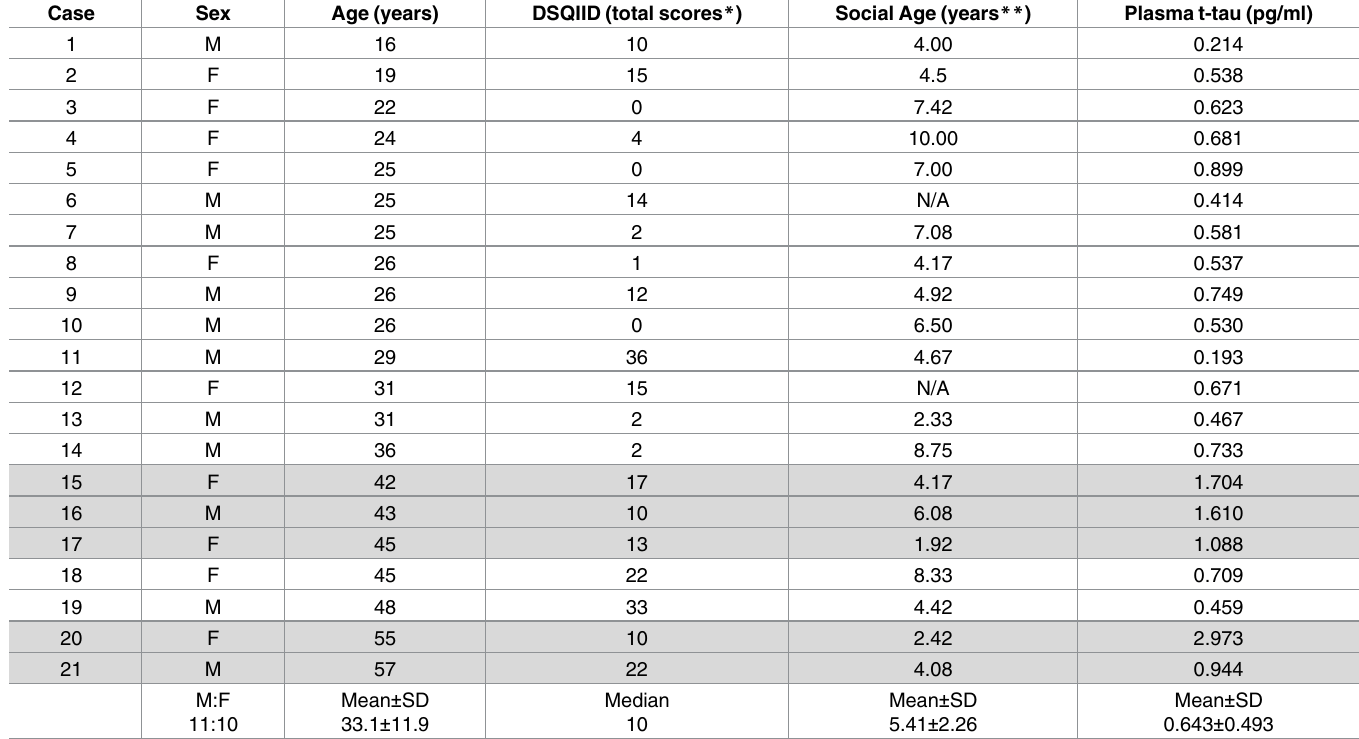
Table 2. Cognitive assessments and concentrations of plasma t-tau in patients with